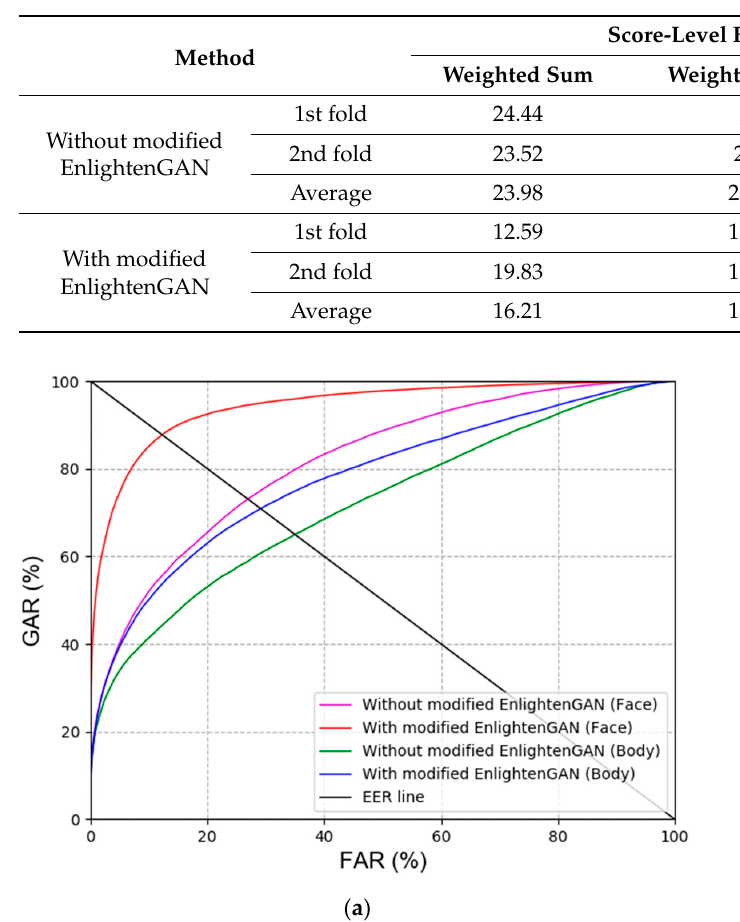
Table 14. Comparisons of EER for score-level fusion with and without modified EnlightenGAN (unit: %).